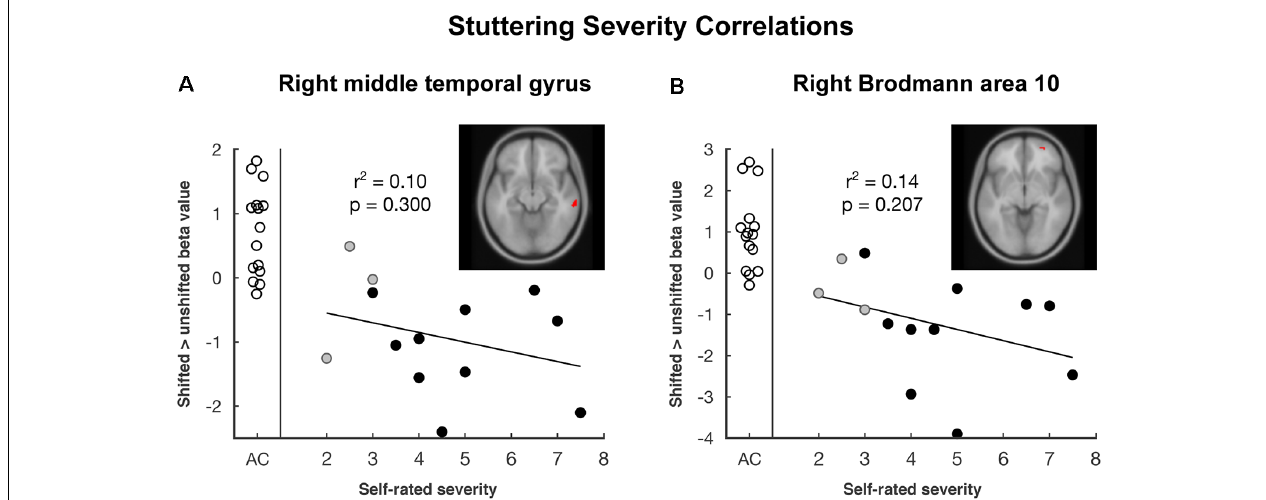
FIGURE 4 | The plot of pitch-shift related activation by self-rated stuttering severity in areas where there was a group difference: (A) right middle temporal gyrus and (B) right Brodmann area 10. Empty circles represent adult control participants (AC), black and gray circles represent adults who stutter (AWS). Gray circles are self-identified AWS whose stuttering was not confirmed by speech-language pathologist evaluation. The trend line and correlation are shown within the AWS